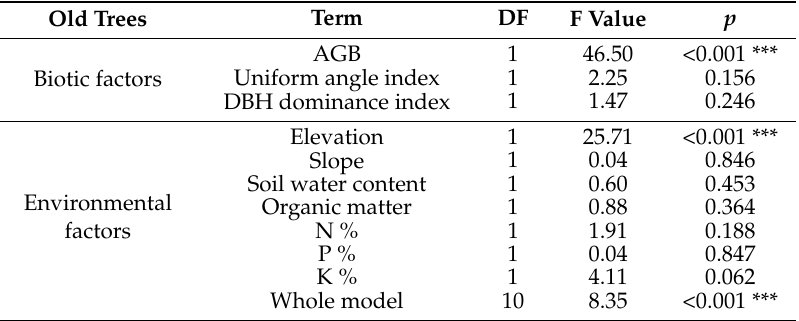
Table A3. Summary of general linear models for the effects of biotic factors and environmental factors on the richness of old